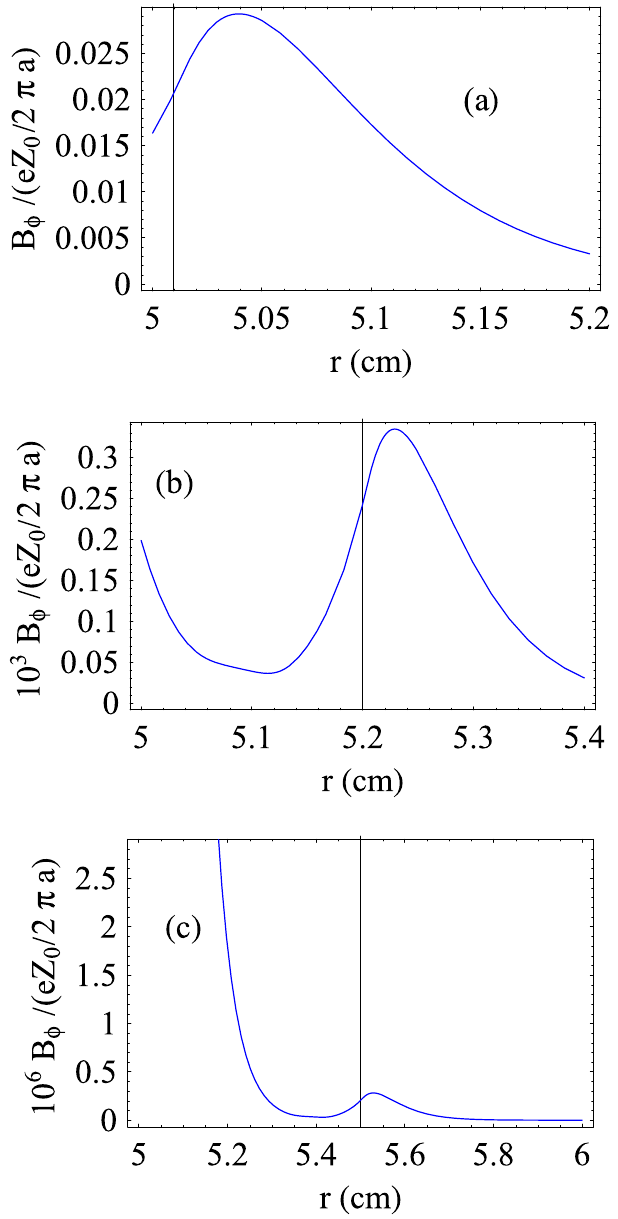
(a) (cid:1) ¼ 0 : 01 cm , (b) (cid:1) ¼ 0 : 2 cm , and (c) (cid:1) ¼ 0 : 5 cm . The other parameters were: a ¼ 5 cm , stainless-steel wall conductivity (cid:2) ¼ 1 : 4 (cid:2) 10 4 (cid:2) (cid:1) 1 cm (cid:1) 1 , (cid:8) ¼ 0 : 04 , and the : 042 cm . The radial behavior shows the resonance char- acter caused by reflection from the slot.